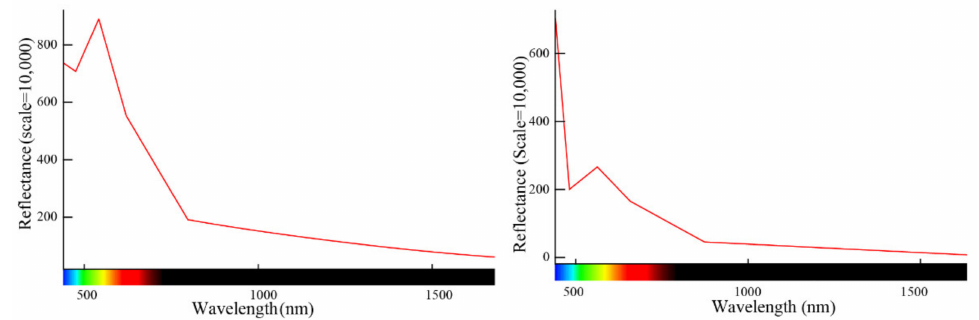
Figure 6. Corrected results of water surface reflectance for Landsat-8